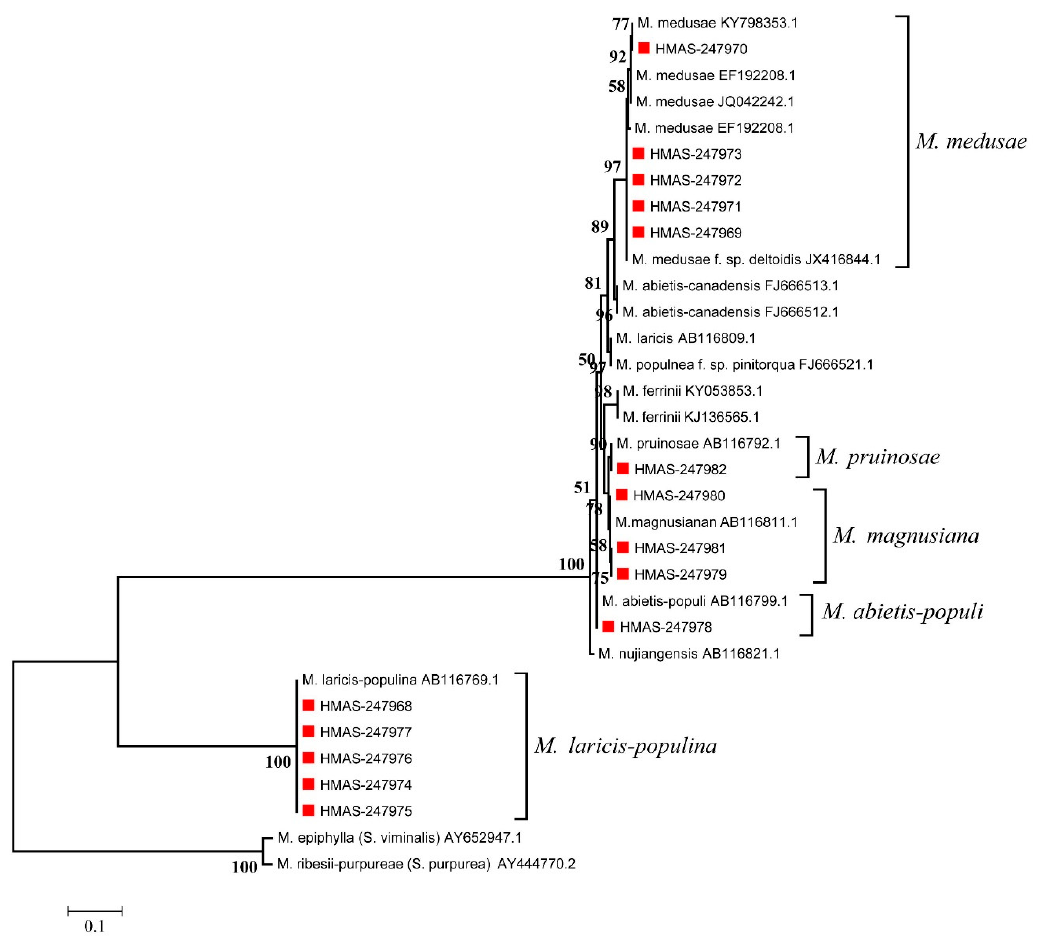
Figure 5. Maximum likelihood (ML) phylogenic tree of 28S rDNA(D 1 /D 2 ) regions. Note: Bootstrap values >50% are shown and red marks are specimens we collected.